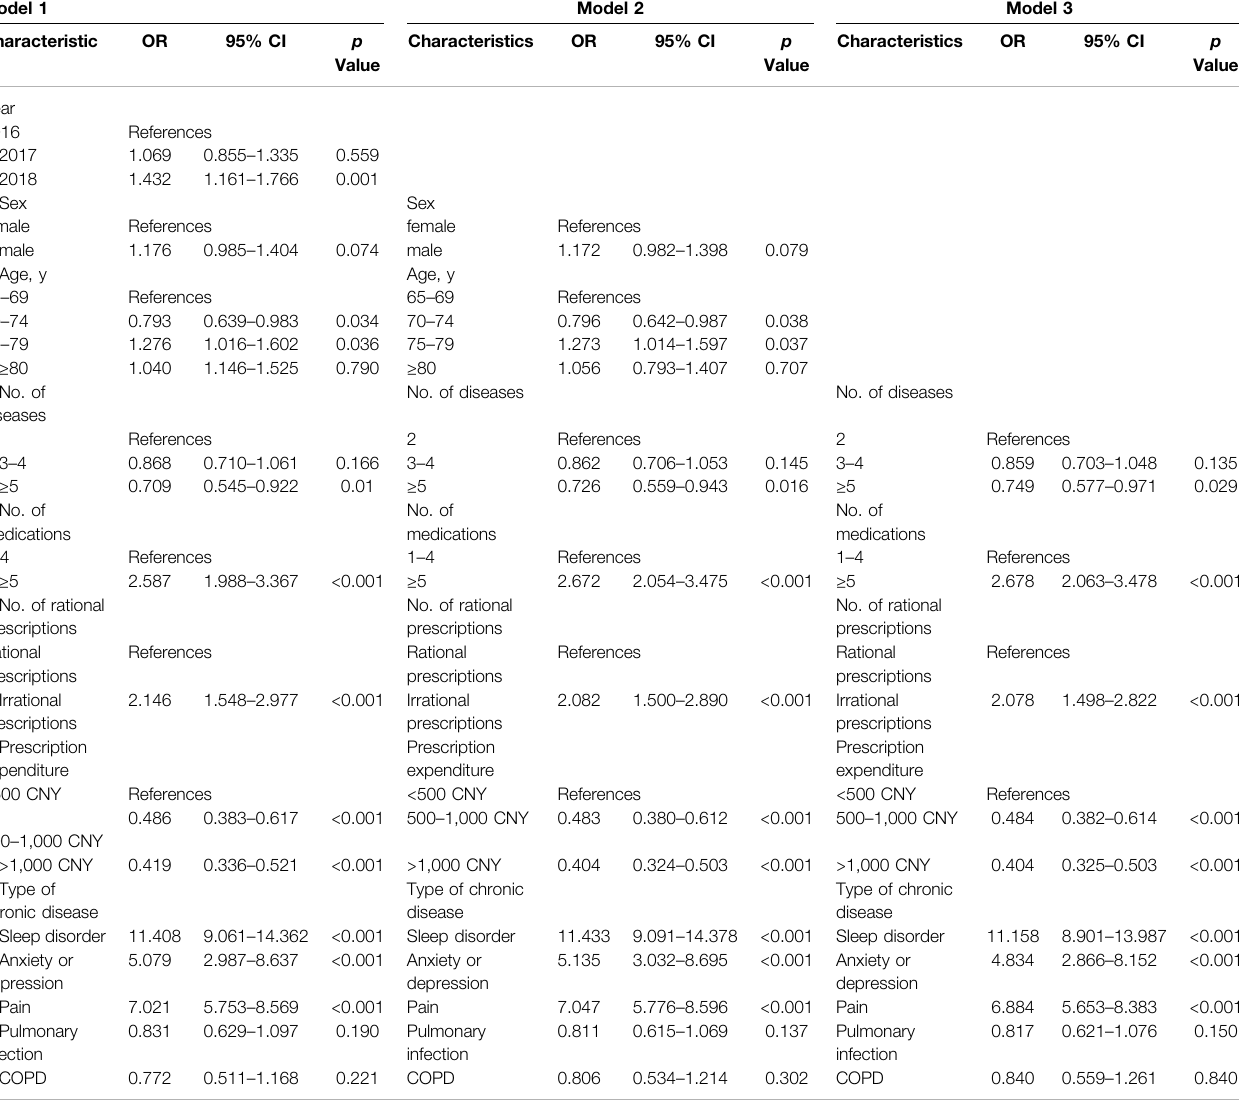
TABLE 4 | Multivariate logistic regression analysis of factors associated with PIM